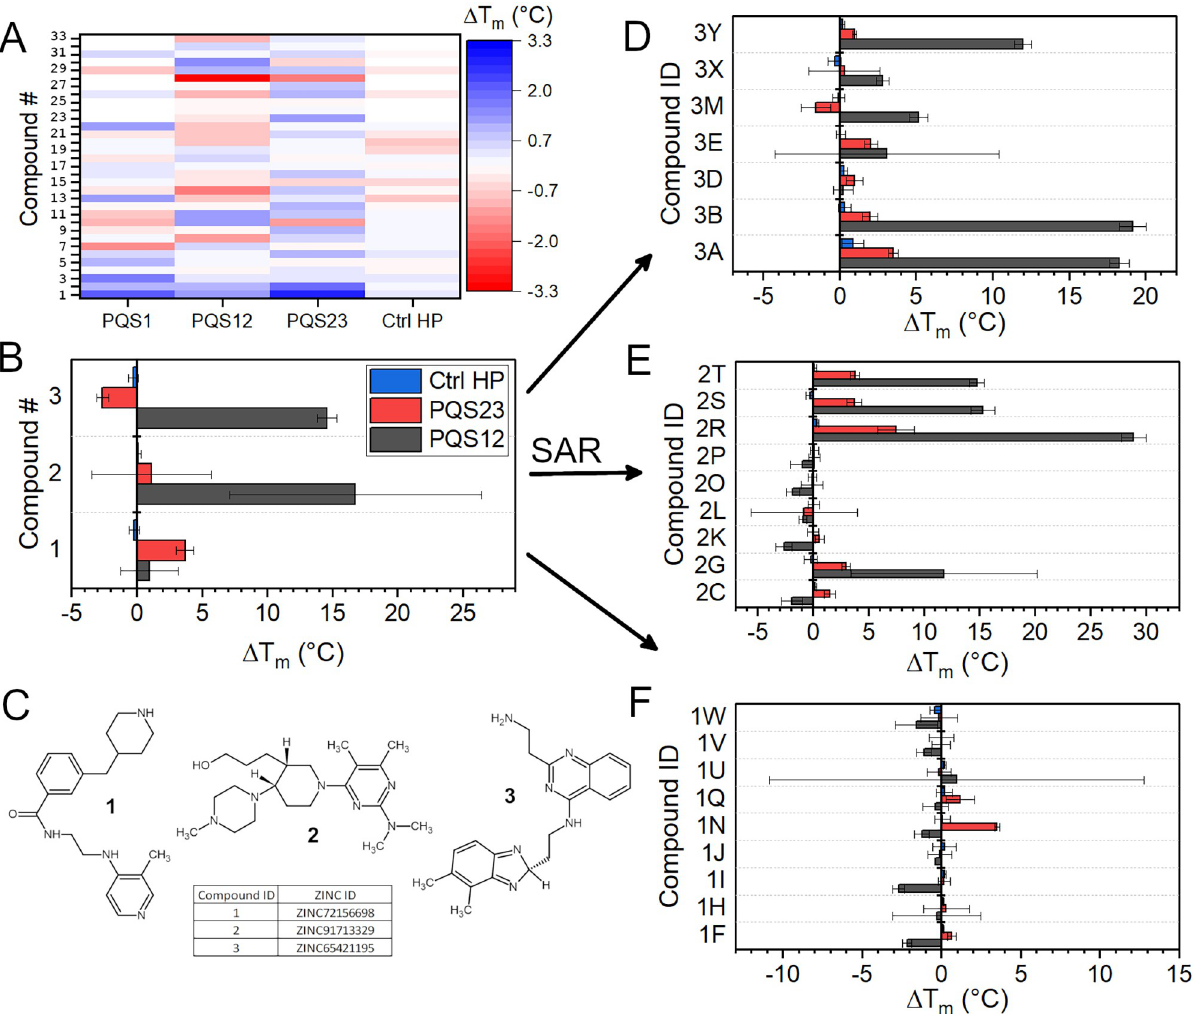
Fig 2. FTSA drug screening and “Catalogue” SAR. (A) Heatmap of Δ T m s for 33 of the original 69 compounds identified in virtual screens plotted against the given hTERT sequences (numbering is arbitrary, compounds not shown had no apparent effect on T m , and were not further pursued). The initial screen was performed at a potassium concentration of 185 mM K + . (B) Re-analysis of compounds 1–3 from A at a lower potassium concentration of 100 mM K + . (C) Structures and ZINC IDs of compounds 1–3. (D-F) FTSA analyses of the SAR compounds derived from 1–3. All FTSA results are given as averages of triplicate measurements from three independent days. Whiskers represent the standard deviation about the mean.